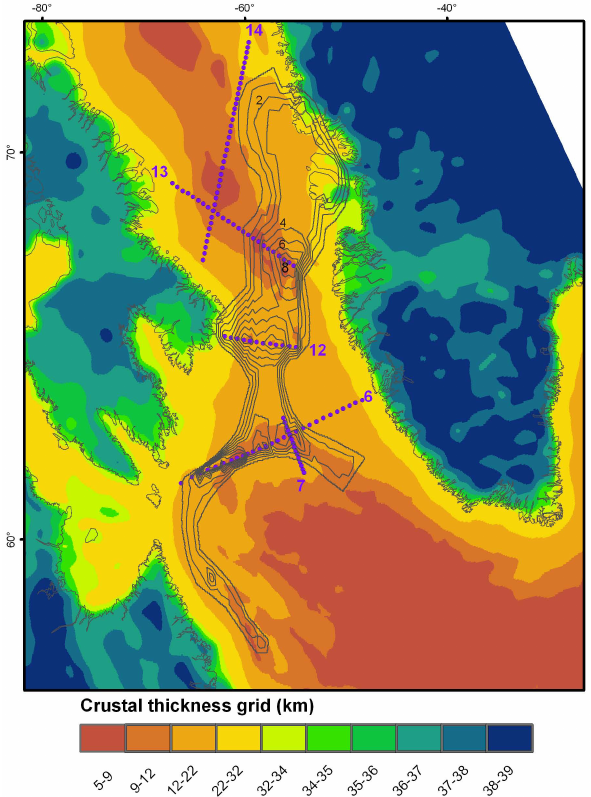
Fig. 8. The crustal thickness grid after elimination of igneous layers. Thin grey contour lines show the extent and the amount of igneous crust in km. Seismic data that has been used in determining the amount and distribution of igneous material have been shown in violet circles. The seismic line numbers are the same as Fig.